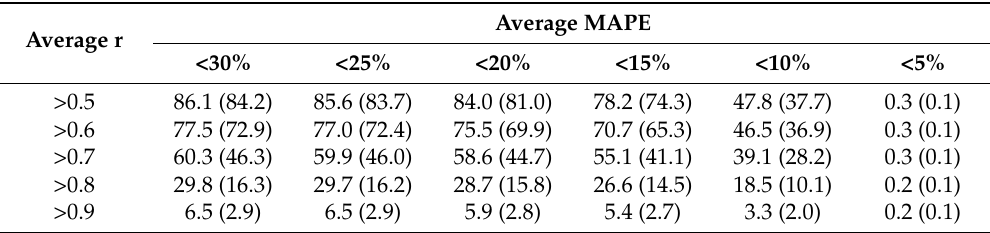
Table 5. The percentage of 1224 large buildings with an average MAPE lower than 30% and an average r greater than 0.5 with ten validation data sets for models A and B (in brackets). Average Average r